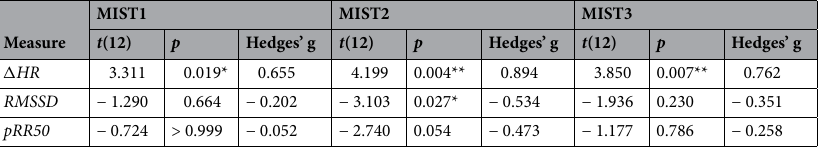
Table 1. HR(V) responses to AT of the Control condition. Paired t-tests were performed between BL and AT subphases for each individual MIST phase.